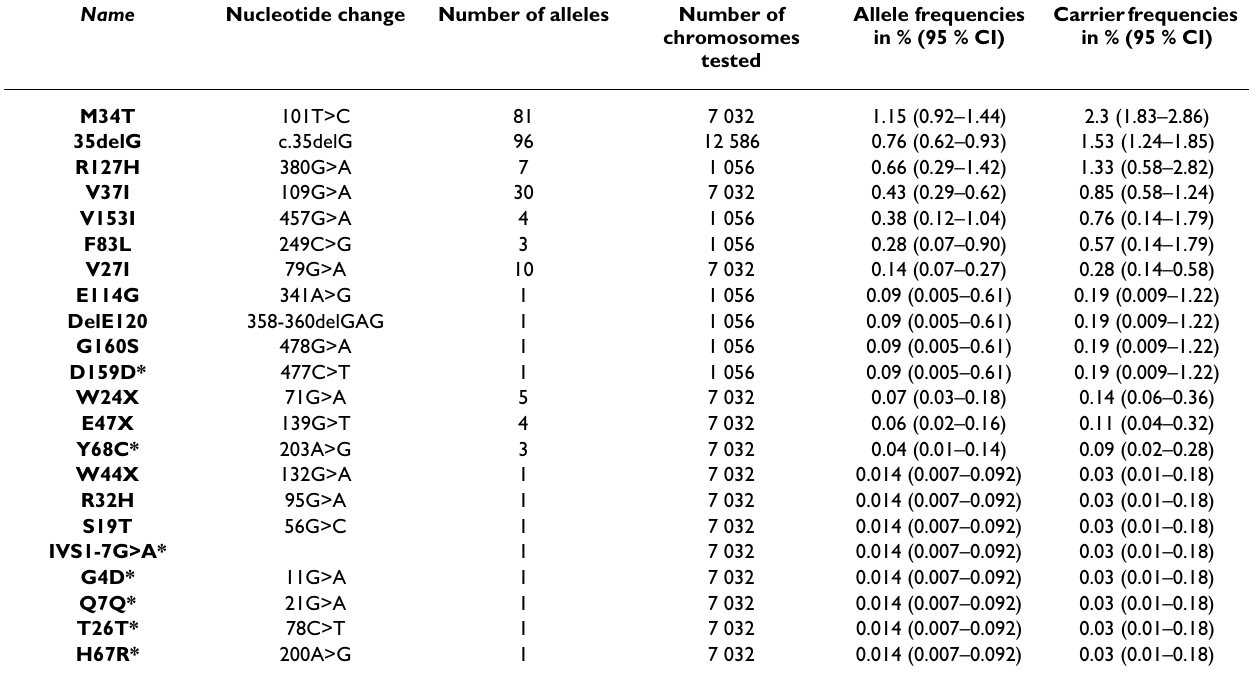
Table 4: Frequencies of the sequence variations identified in the general population from